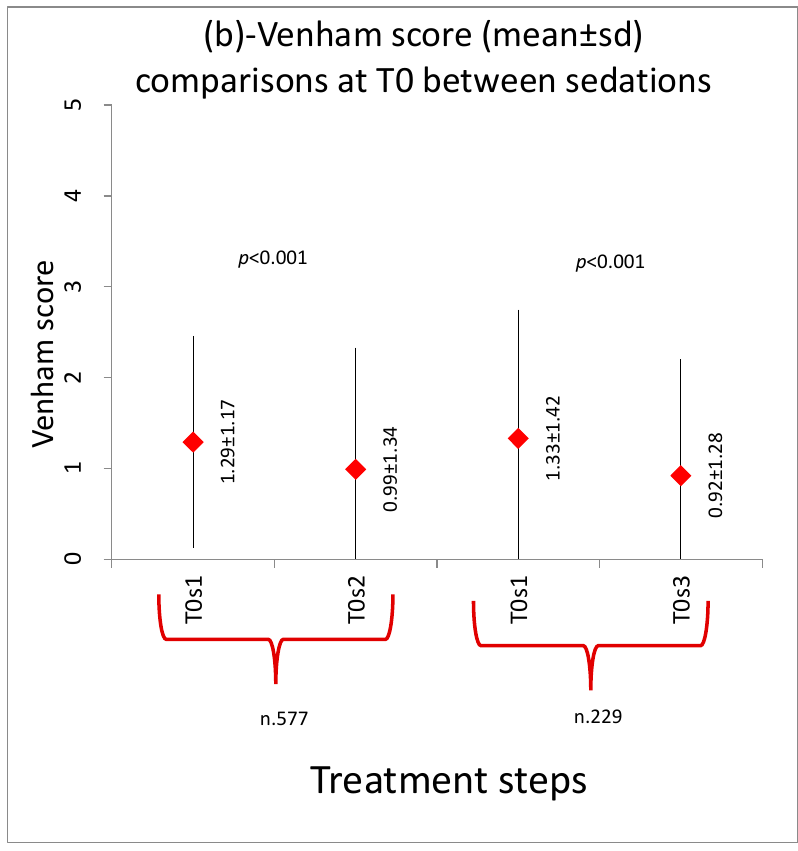
Figure 4. ( a ) Venham score comparisons at Tc (first contact with the dentist) and ( b ) Venham score comparisons at T0 (at the time of mask placement) between the first (s1) and the second sedation (s2) and between the first (s1) and the third sedations (s3).